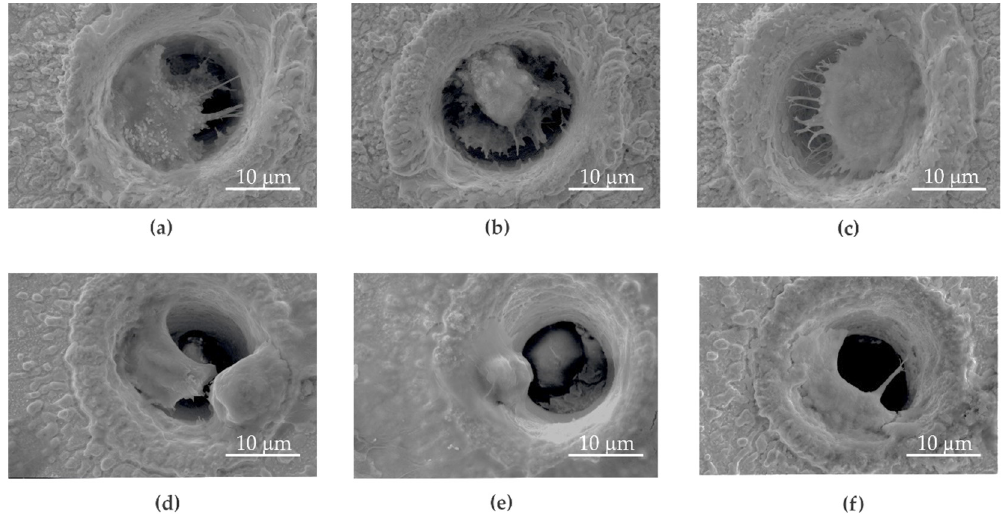
Figure 4. SEM images of a DU 145 cell on the Ni ( a – c ) and Ni + GO ( d – f ) sieves. Studies on the efficacy of DU 145 screening at the microsieves Au, Au + GO, Ni, and Ni + GO were conducted with the prostate cancer cell line DU 145. A suspension of PBS + DU 145 (10 mL) was placed in a uniform flooding reservoir that leaked through the sepa- rator by gravity. During this time, the cancer cells nested in the holes and isolated them- selves on the microsieves. The methodology of the cell screening process is described in Sections 4.4 and 4.5.